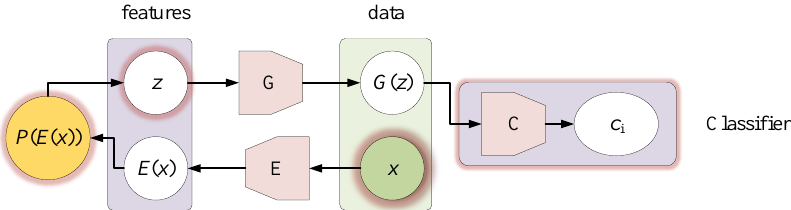
Figure 9. The model structure for practical application. Just input the spectrum to be classified at x , and the predicted category c i will be output.